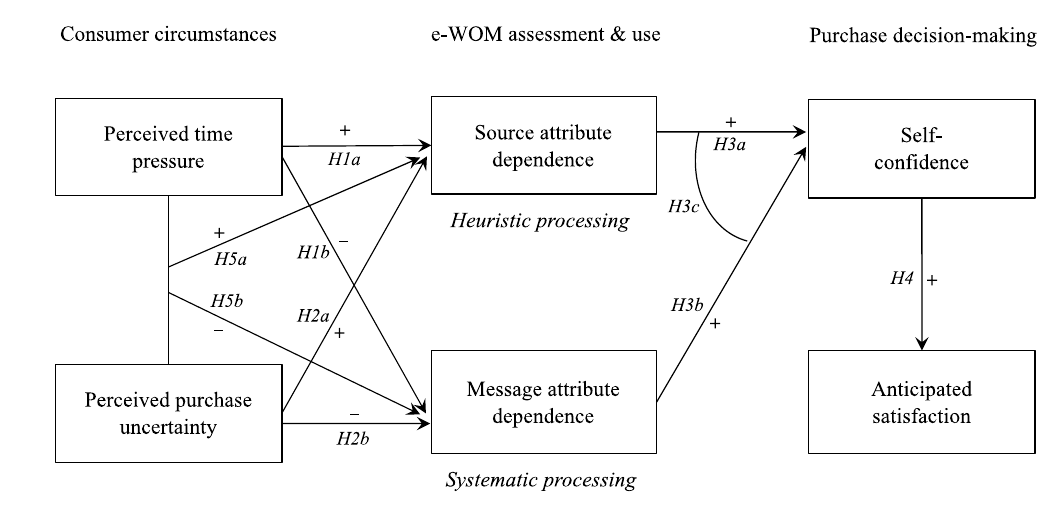
Figure 1. Research model.